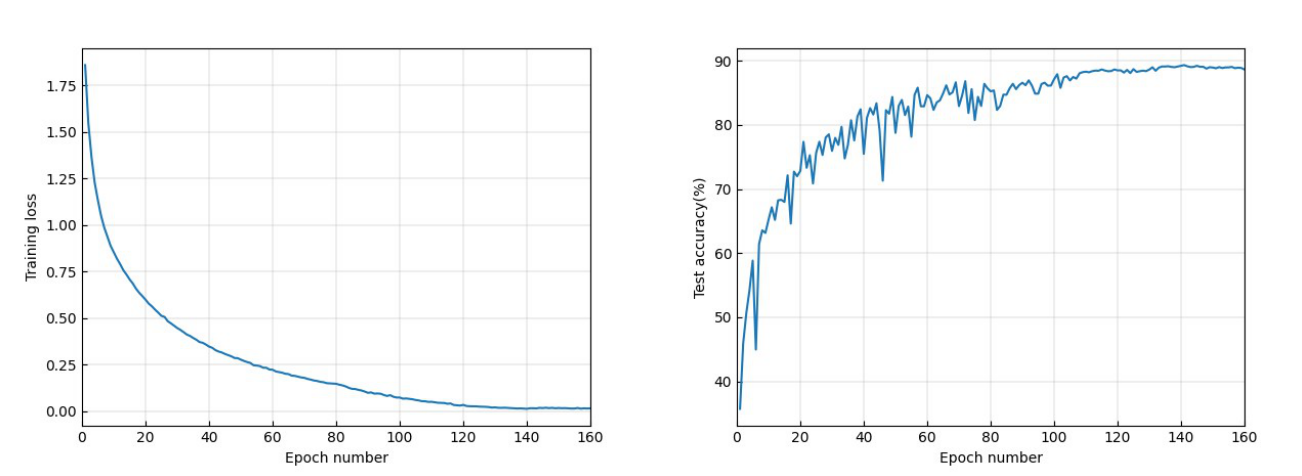
Figure A4. Training PreResNet-164 on CIFAR-10.